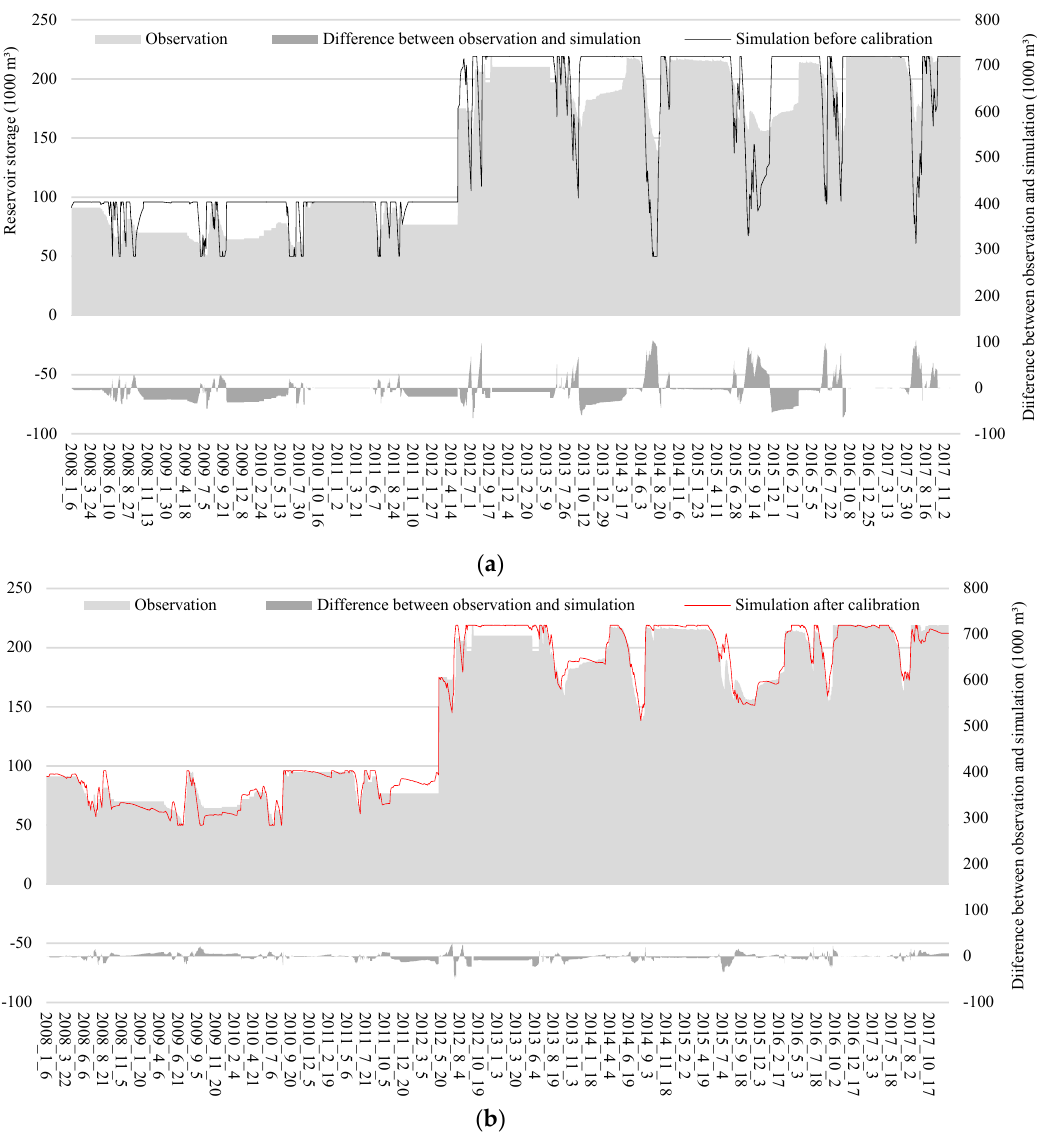
Figure 6. Simulation of water storage capacity of Samchun reservoir before and after calibration using RCFs. ( a ) Before calibration (Samchun reservoir); ( b ) after calibration (Samchun reservoir).